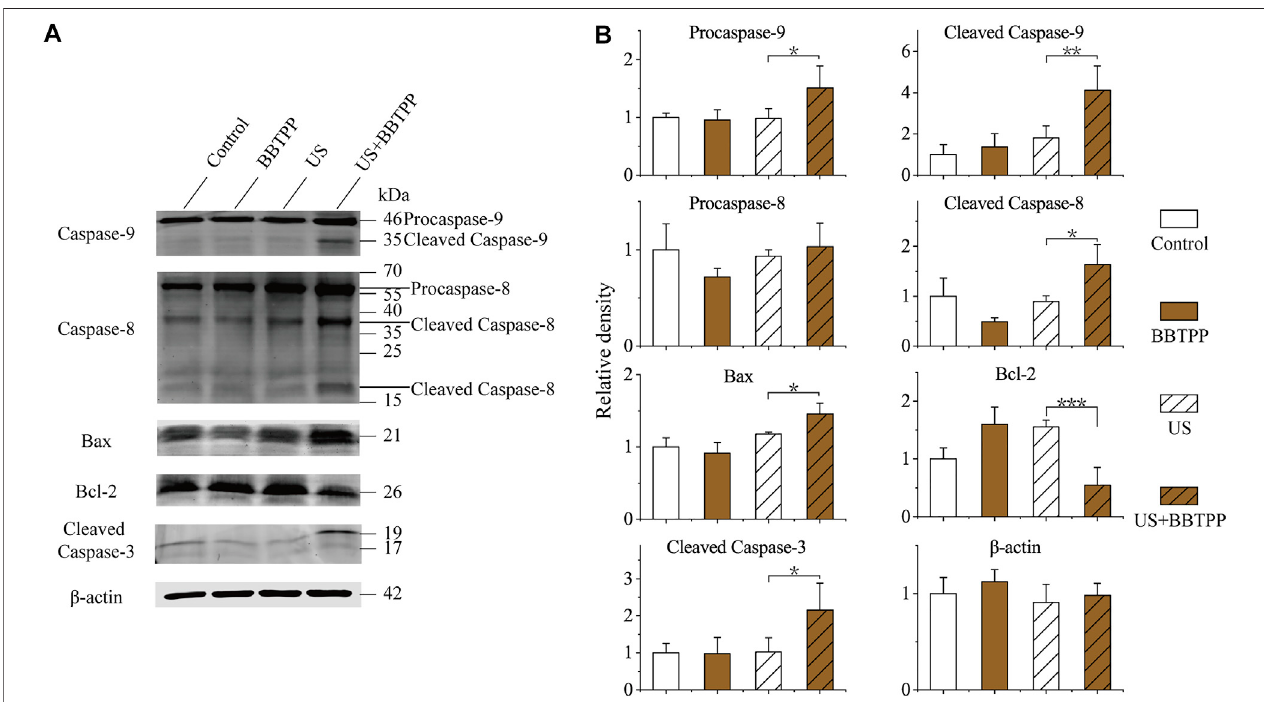
FIGURE 4 | Western blot analysis of endogenic expression of caspase-9, caspase-8, Bax, Bcl-2, cleaved caspase-3, and β -actin in PC-9 cells with different treatments (A) Representativeimmunoblottingimages (B) Relativeexpressionofapoptosis-relatedproteins.Thedatawerepresentedasthemean ± standarddeviation. US: ultrasound; * p ＜ 0.05, ** p ＜ 0.01, *** p ＜